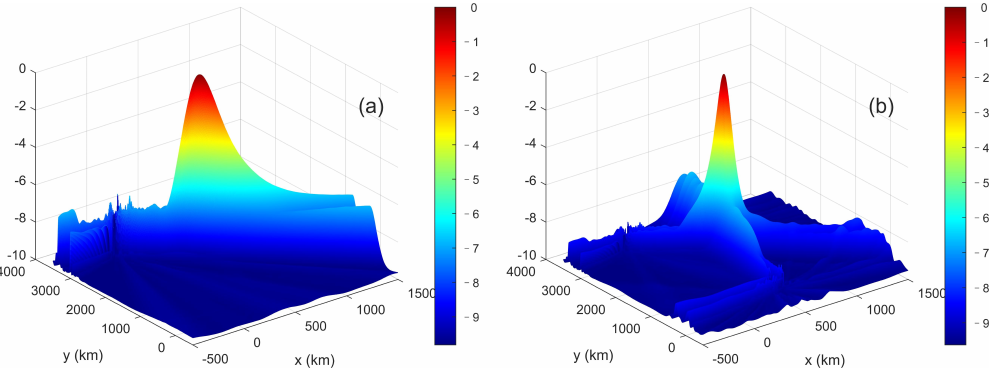
Figure 8. (Color online) 3D spatial spectra of GMA ( a ) and N-MUSIC ( b ) with 198 Hz at segment